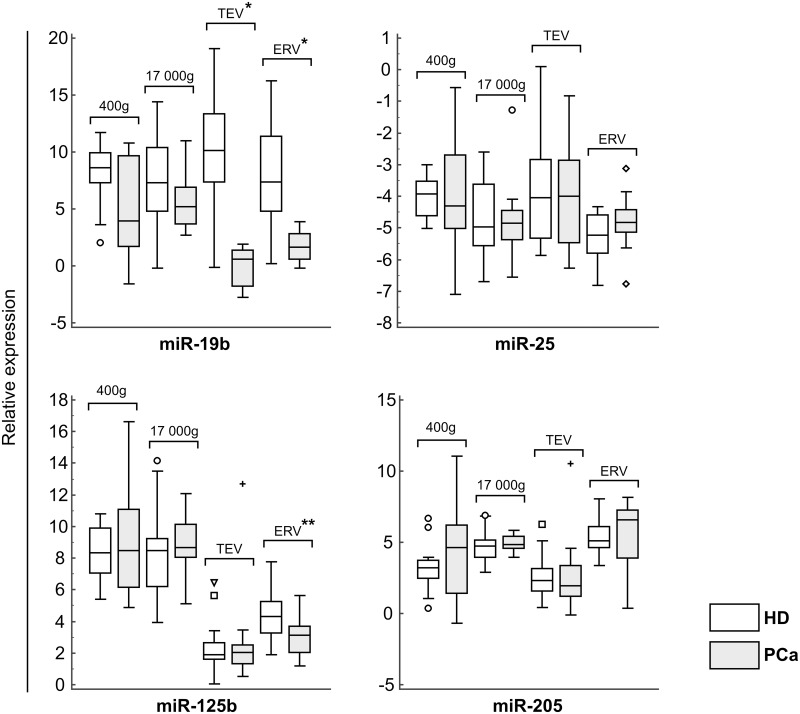
Relative miRNA expression in urine EVs.Tukey box plots of miRNA expression in all fractions of urine. Asterisks (*) indicate statistical significance. *P<0.0001; **P = 0.0150.